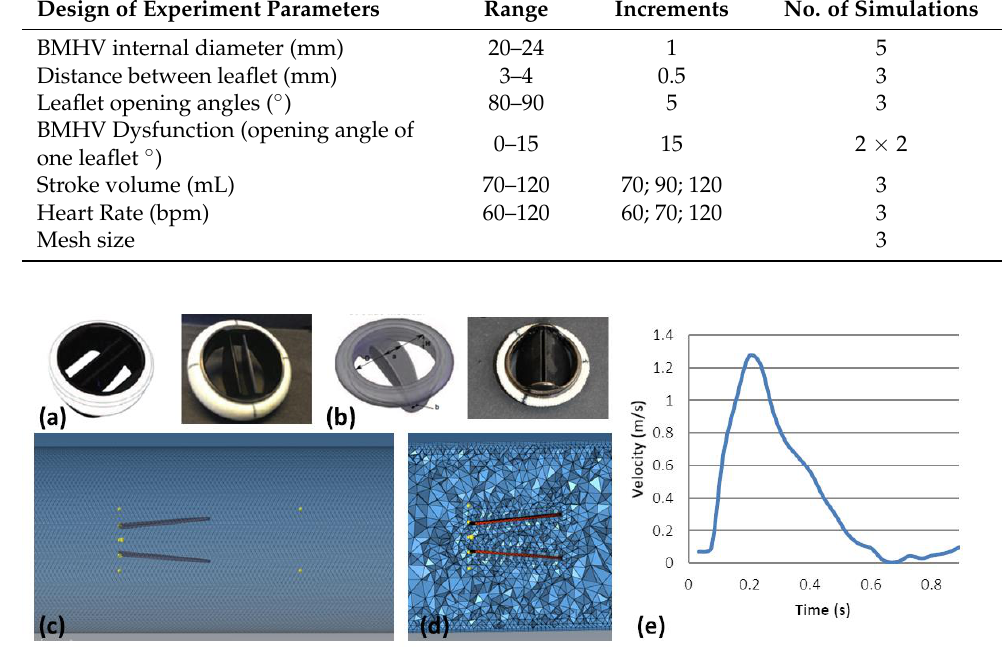
Figure 2. Parametric numerical simulation. BMHV designs: OnX ( a ) and St Jude Medical ( b ), Numerical simulation settings: BMHV in the tube ( c ) and details of computational mesh ( d ), and inflow velocity curve ( e ). Table 3. Numerical simulation setting (geometrical parameters of the BMHV) and results: EOA AST computation (mean, max, and mean) and location of the recording plane.